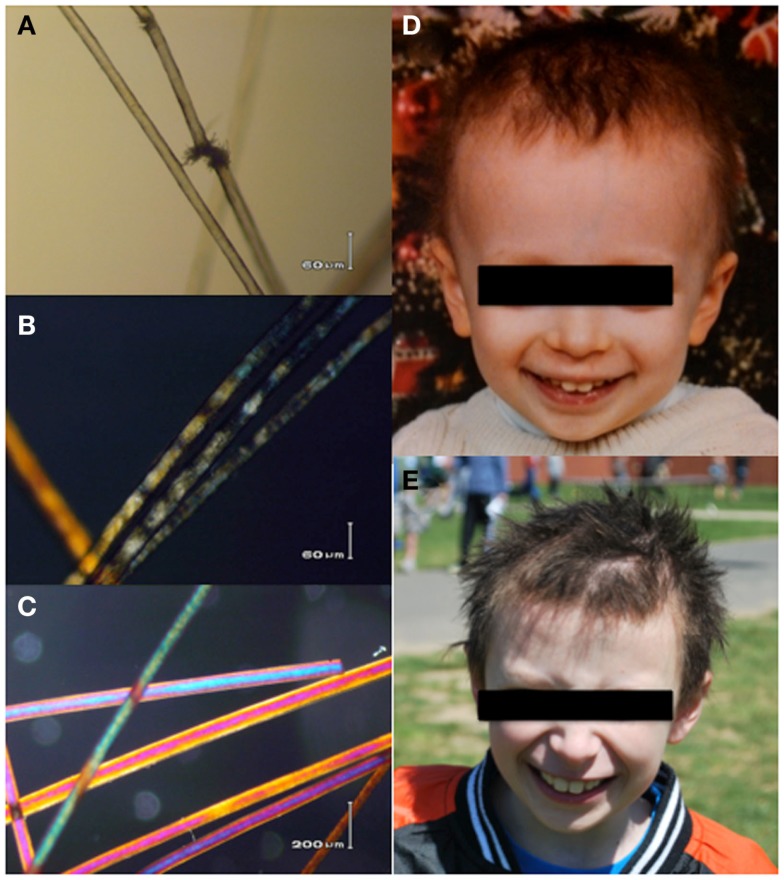
The patients hair shafts have trichorrhexis nodosa-like defects (A), and under polarizing microscopy (B) show a somewhat irregular banding pattern reminiscent of, but distinct from the tiger tail banding characteristic of trichothiodystrophy. These are not seen in the polarized view of hair shafts from his brother (C). Pastel colors are artifacts. (D,E) Show the patients facial features and gross hair morphology at ages 2 and 10 years, respectively. Hair analysis and photos compliments of Alan Zhou, John J. DiGiovanna, Deborah Tamura, and Kenneth H. Kraemer. Patient photos courtesy of the family archive, used with permission.